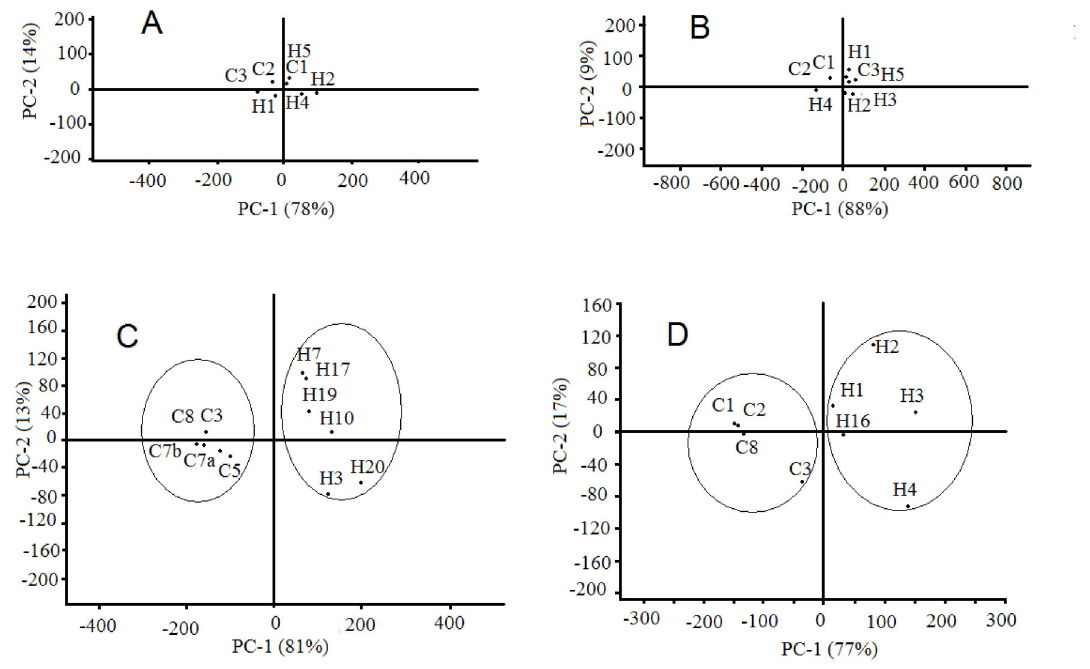
Figure 4. Principal component analysis of HPLC-MS leaf metabolites from ‘Valencia’ and ‘Hamlin’ trees. A ) score plot of leaf metabolites from ‘Valencia’ trees 3 weeks after inoculation; B ) score plot of leaf metabolites from ‘Hamlin’ trees 3 weeks after inoculation; C ) score plot of leaf metabolites from ‘Valencia’ trees 38 weeks after inoculation; D ) score plot of leaf metabolites from ‘Hamlin’ trees 38 weeks after